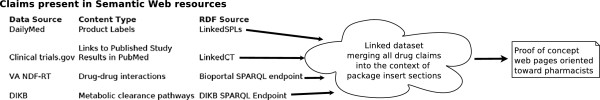
The architecture of the proof-of-concept system described in this paper that demonstrates the dynamic enhancement of drug product labels using Semantic Web technologies.